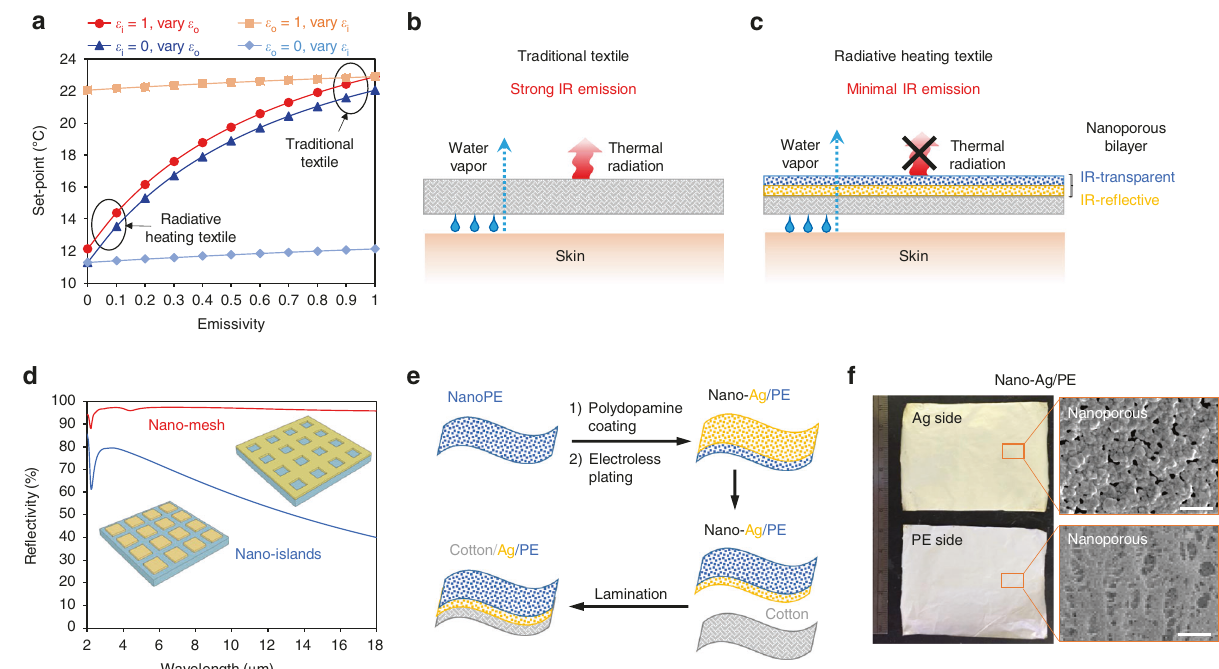
Fig. 1 Simulation and fabrication of radiative heating textile. a Simulated set-points of ambient temperature for maintaining thermal comfort as a function of the textile ’ s IR emissivity at the inner surface ( ε i ) and outer surface ( ε o ). Schematics depicting the heat dissipation and vapor transmission of human body covered with b traditional textile and c nanophotonic structure heating textile composed of an IR-transparent layer and an IR-re fl ective layer with embedded nanopores in both layers to simultaneously achieve minimal IR emissivity and good breathability. d Simulated total IR re fl ectance of metallic nano-island fi lm and metallic nano-mesh fi lm with coverage density of 81%. The island size is 900 nm × 900 nm. The hole size is 440 × 440 nm. For both cases, the period is 1 µ m × 1 µ m. e Schematic representation of the fabrication process of nano-Ag/PE textile, which is laminated on the outer surface of cotton. f Photos and SEM images of the Ag side and PE side of nano-Ag/PE. Scale bar , 1 µ